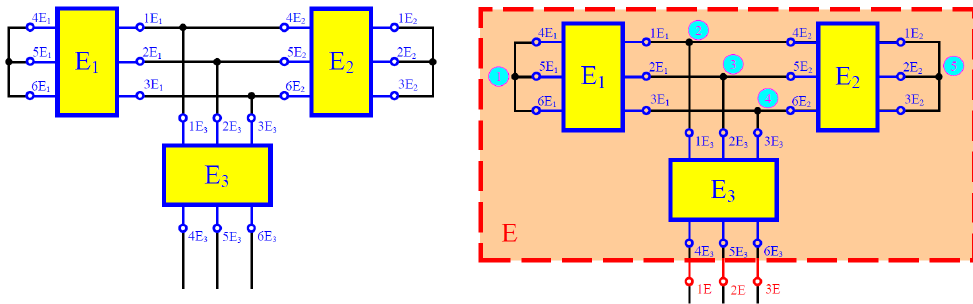
Figure 9. Schematic diagram of a fragment of the electrical system in which structural elements are aggregated and a diagram of the equivalent structural